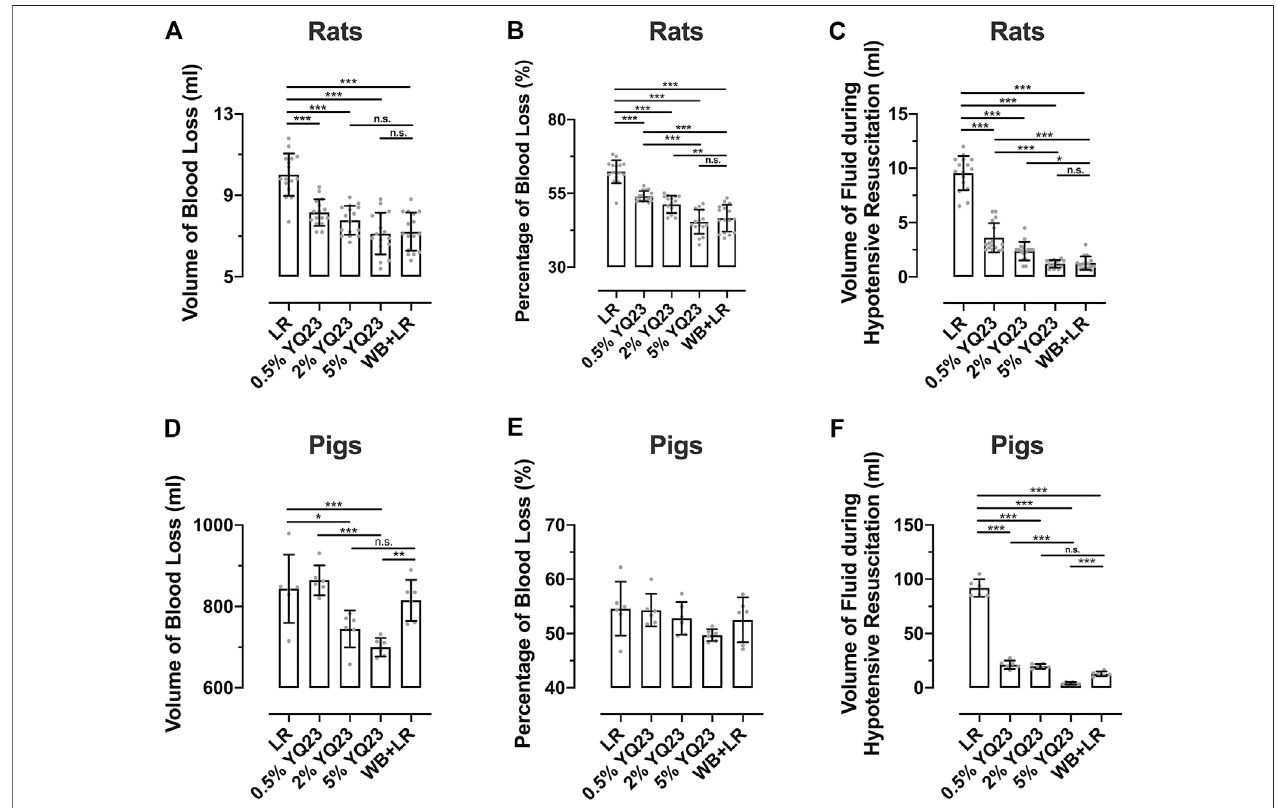
FIGURE 2 | YQ23 decreased the blood loss and fl uid demand during hypotensive resuscitation following uncontrolled hemorrhagic shock. ( n (cid:1) 16/ group in rat experiment, n (cid:1) 6/groupin pig experiment). (A) ,the volume ofblood loss inrats; (B) , percentage ofblood loss inrats; (C) , the volume of fl uid required during hypotensive resuscitation in rats; (D) , the volume of blood loss in pigs; (E) , percentage of blood loss in pigs; (F) , the volume of fl uid required during hypotensive resuscitation in pigs. LR, Lactate Ringer ’ s solution; WB, whole blood. * p < 0.05, ** p < 0.01, *** p < 0.001, n. s. not signi fi cant, # n of LR group at the corresponding time point (sample size was decreased because of animal